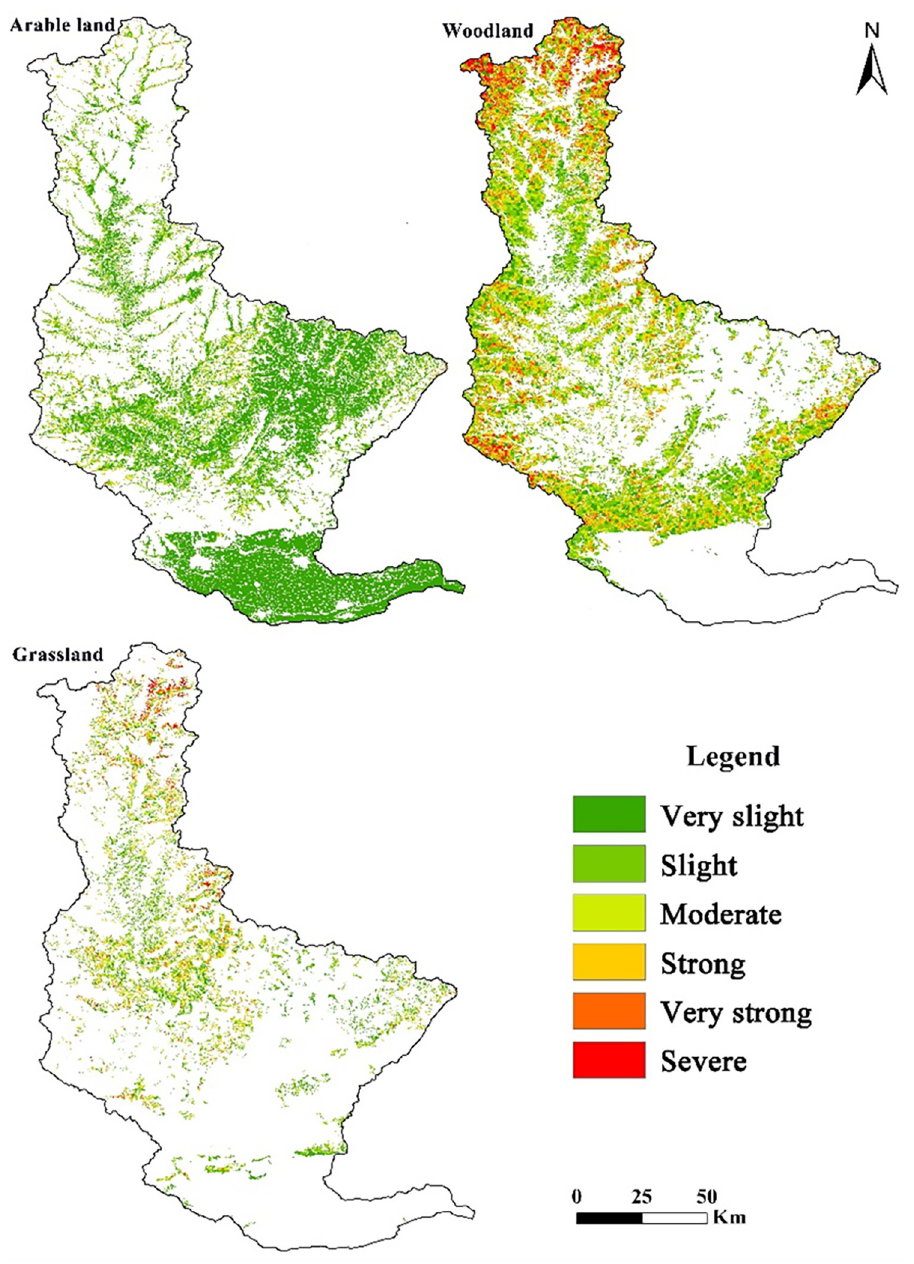
Fig 4. Distribution of the soil-erosion intensity of different land-use types for Qin River Basin. We used ArcGIS software to extract the areas of cultivated land, forest land and grassland, and superimposed soil erosion with the extracted areas to obtain the distribution map of soil erosion intensity for different land uses. The scope of the Qin River Basin was determined based on DEM and eight-direction (D8) algorithm. Based on authors’ field investigation, we have modified and adjusted the vector